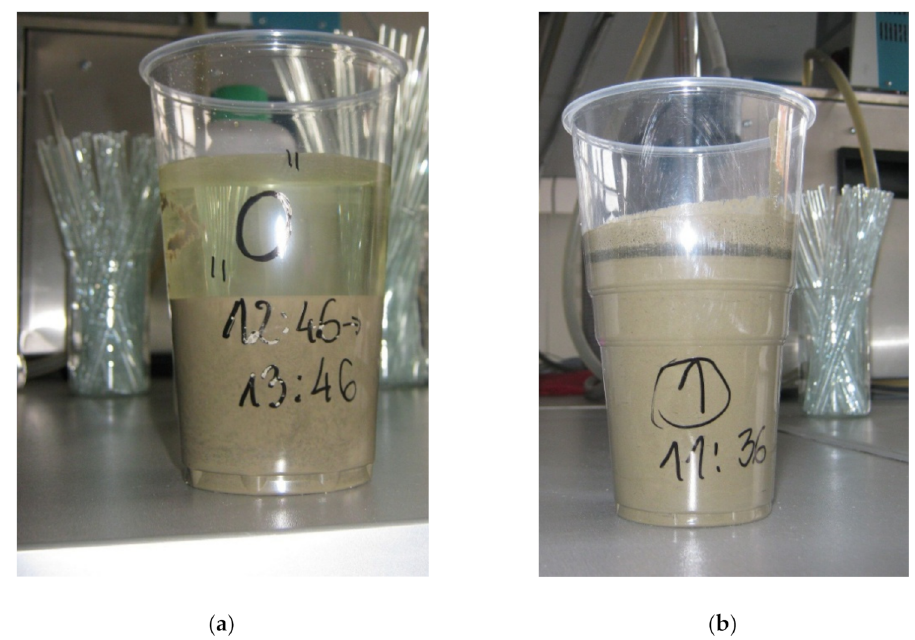
Figure 8. Photos showing sedimentation of pastes: ( a ) paste C0; ( b ) paste